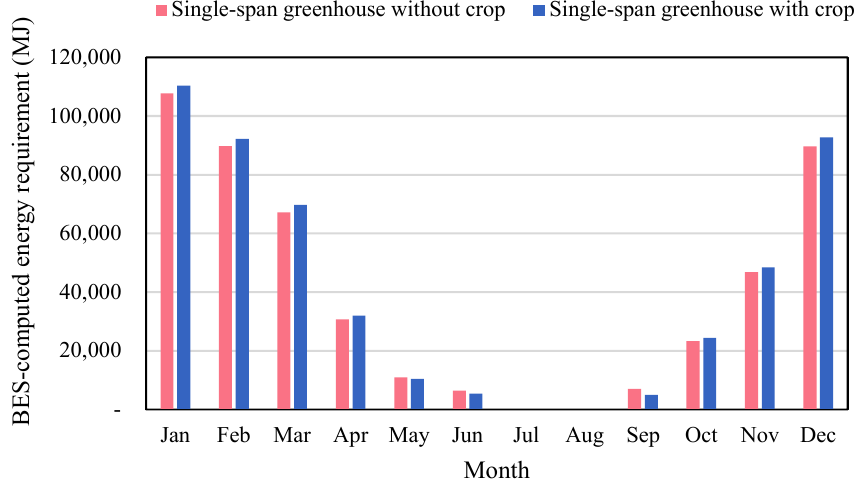
Figure 15. Comparison of monthly energy load in a single-span greenhouse with and without crop.